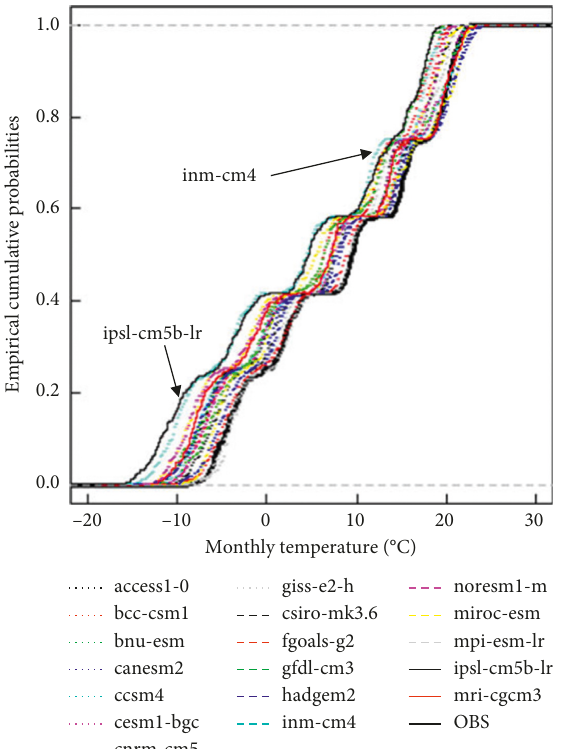
Figure 3: Empirical cumulative probabilities for monthly mean temperature via observations and GCMs.